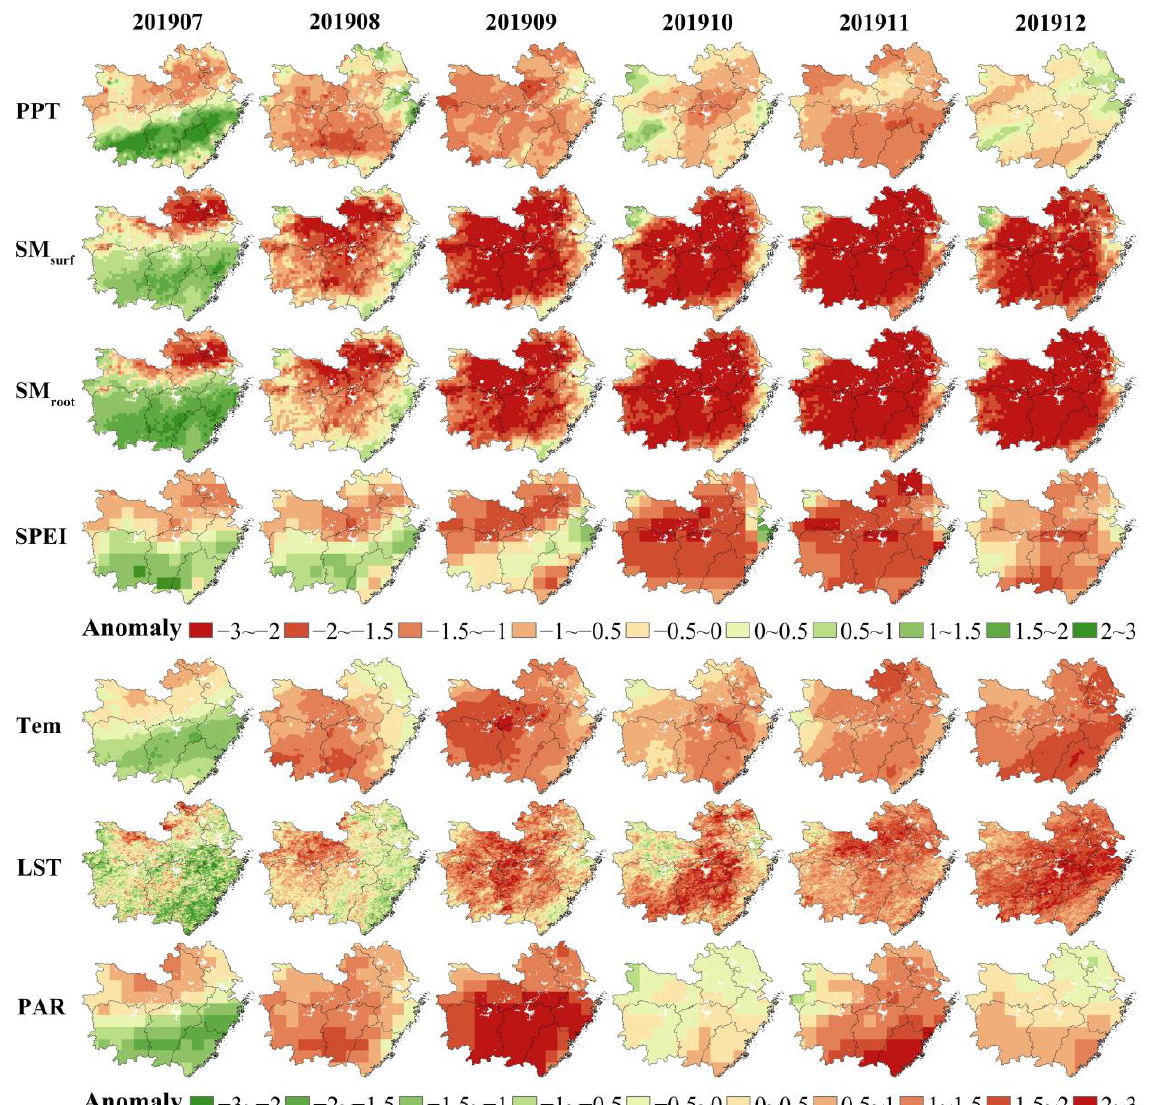
Figure 8. Spatial distributions of the standardized anomalies of PPT, SM surf , SM root , SPEI, Tem, LST, and PAR from July to December 2019.